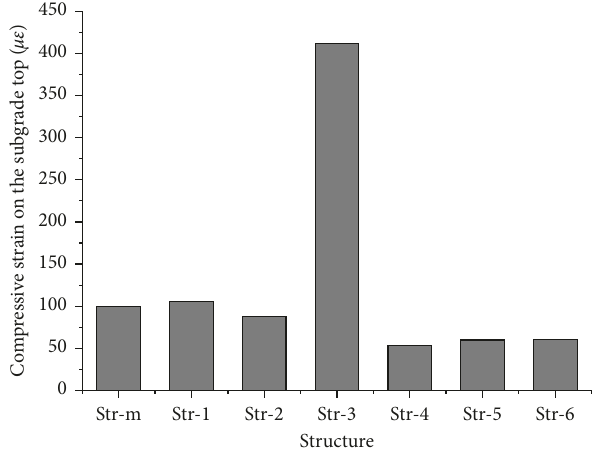
Figure 17: Deflections on the pavement surface of seven pavement structures.